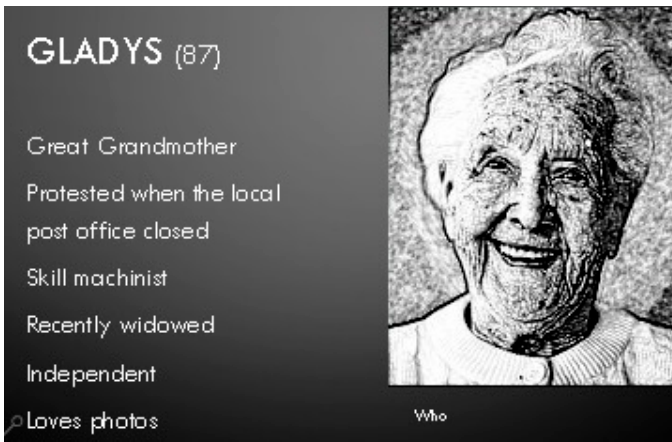
Figure 1. Persona created as a way to tell a story about how an individual may be affected by digital technologies and how this may affect their health.